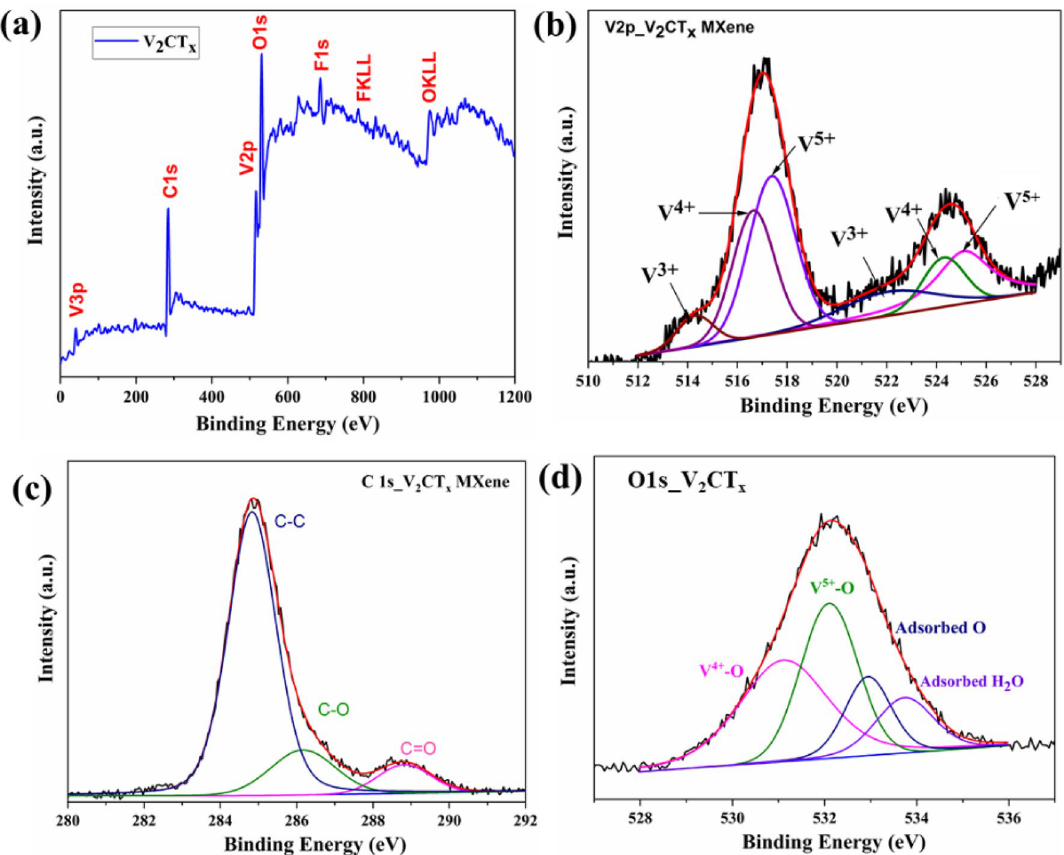
Figure 6. XPS analysis of V 2 CT x MXene: ( a ) total survey, ( b ) V 2p , ( c ) C1s, and ( d ) O1s